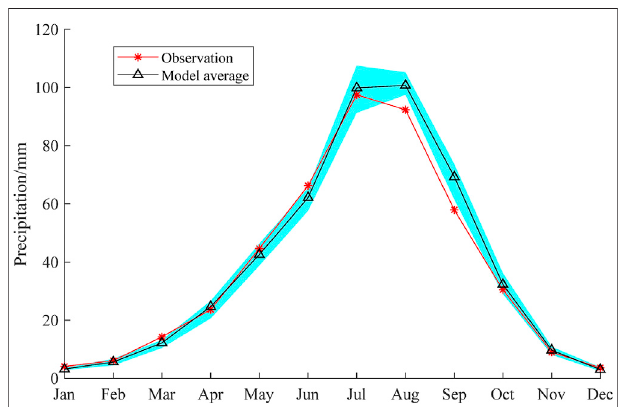
FIGURE 3 | Annual cycle of average monthly precipitation from observation, model average, and range between maximum and minimum of the fi ve CMIP5 models (blue shading) in 1986 – 2005.